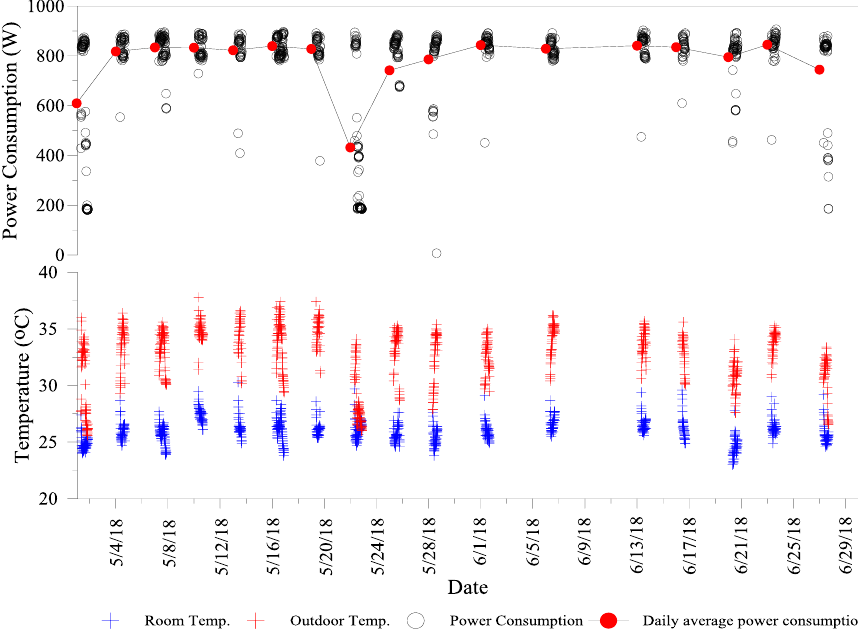
Figure 12. Performance of GSHP 2 (10-min interval data during the operational period).